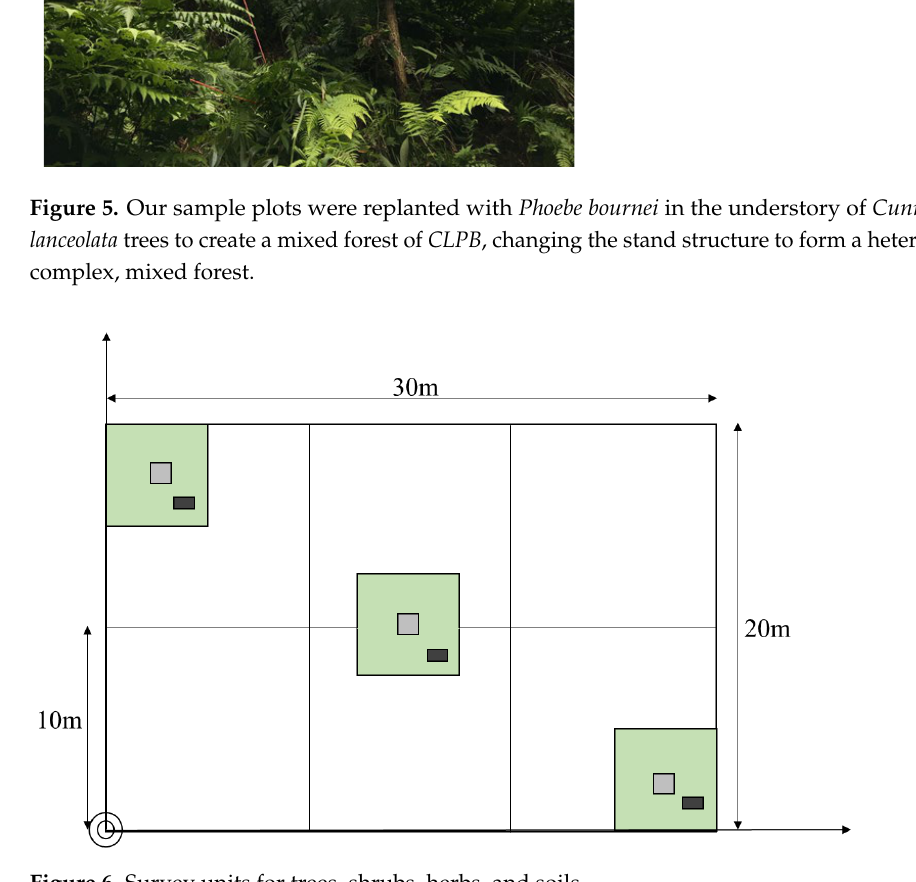
Table 2. Two-dimensional volume table of main trees. Species